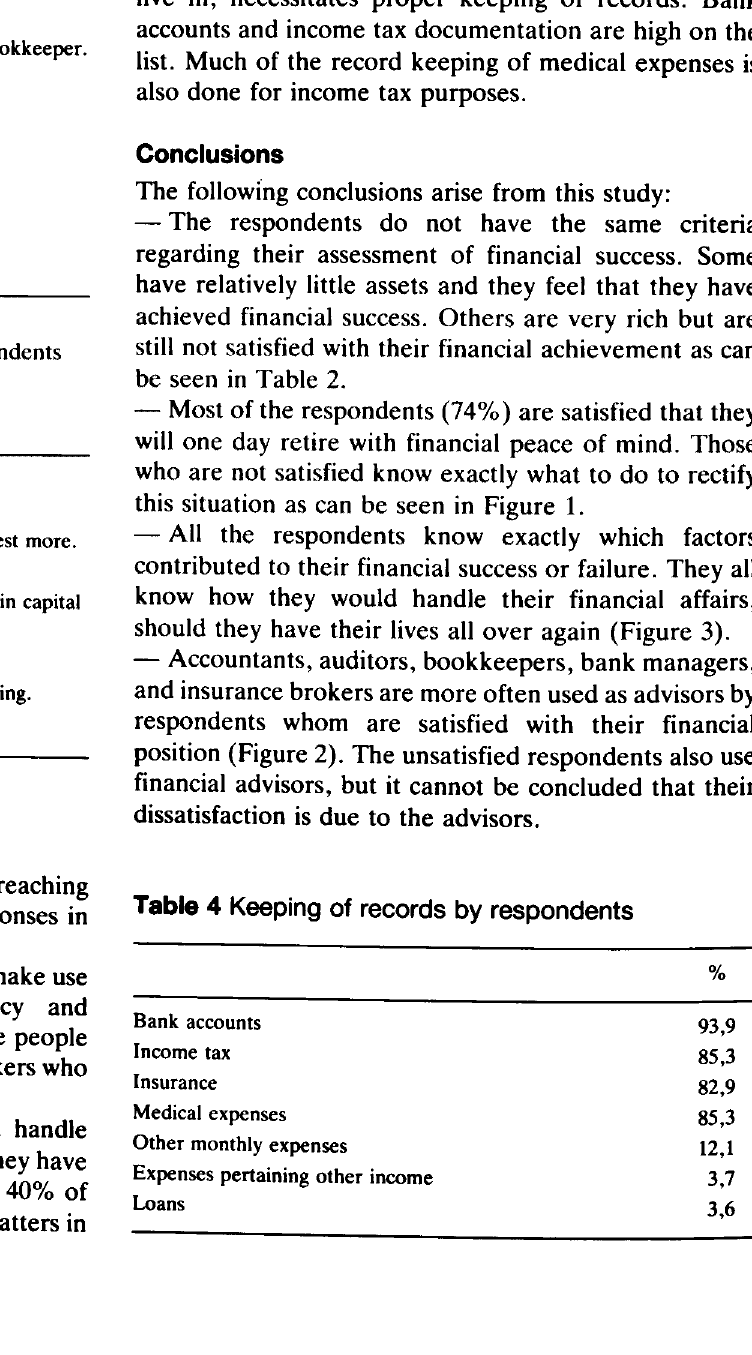
Figure 1 Factors that contributed to financial success/failure